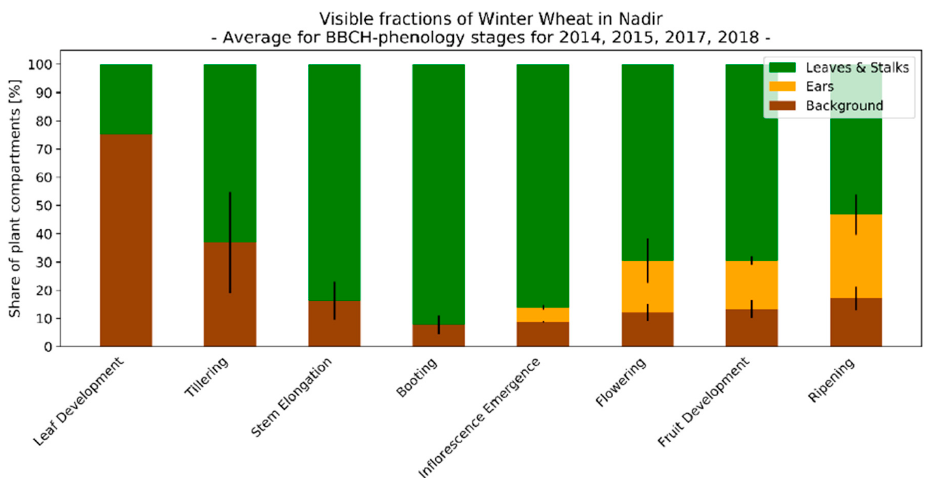
Figure 12. Development of plant fractions of winter wheat canopies as they become visible to a sensor that is observing the respective field in nadir view at different phenological stages, obtained from nadir RGB image segmentation. Black lines within the bars indicate the standard errors of background and ears.